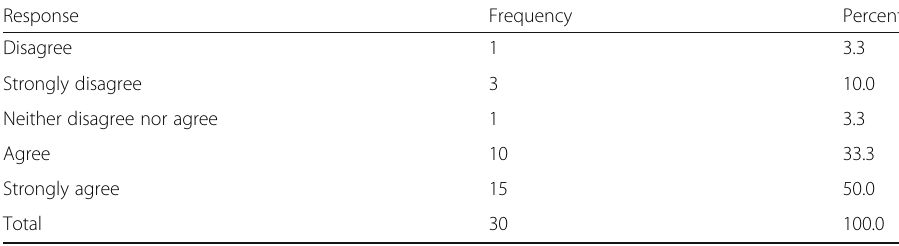
Table 7 Reduced bureaucracy in clearing processes at the sea port Response